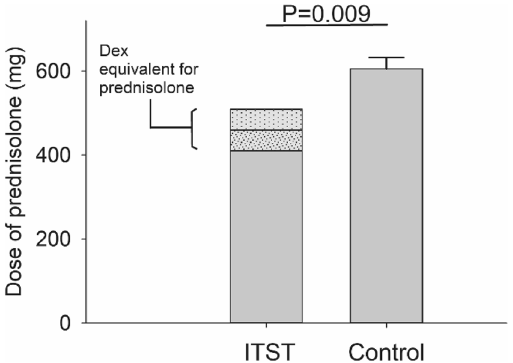
Figure 1. Total amount of prednisolone administered in each group. Dexamethasone 16.5 mg is assumed to be equivalent to 50–100 mg of prednisolone (see “Results”). The equivalent dose was thus regarded as 492.5 mg for